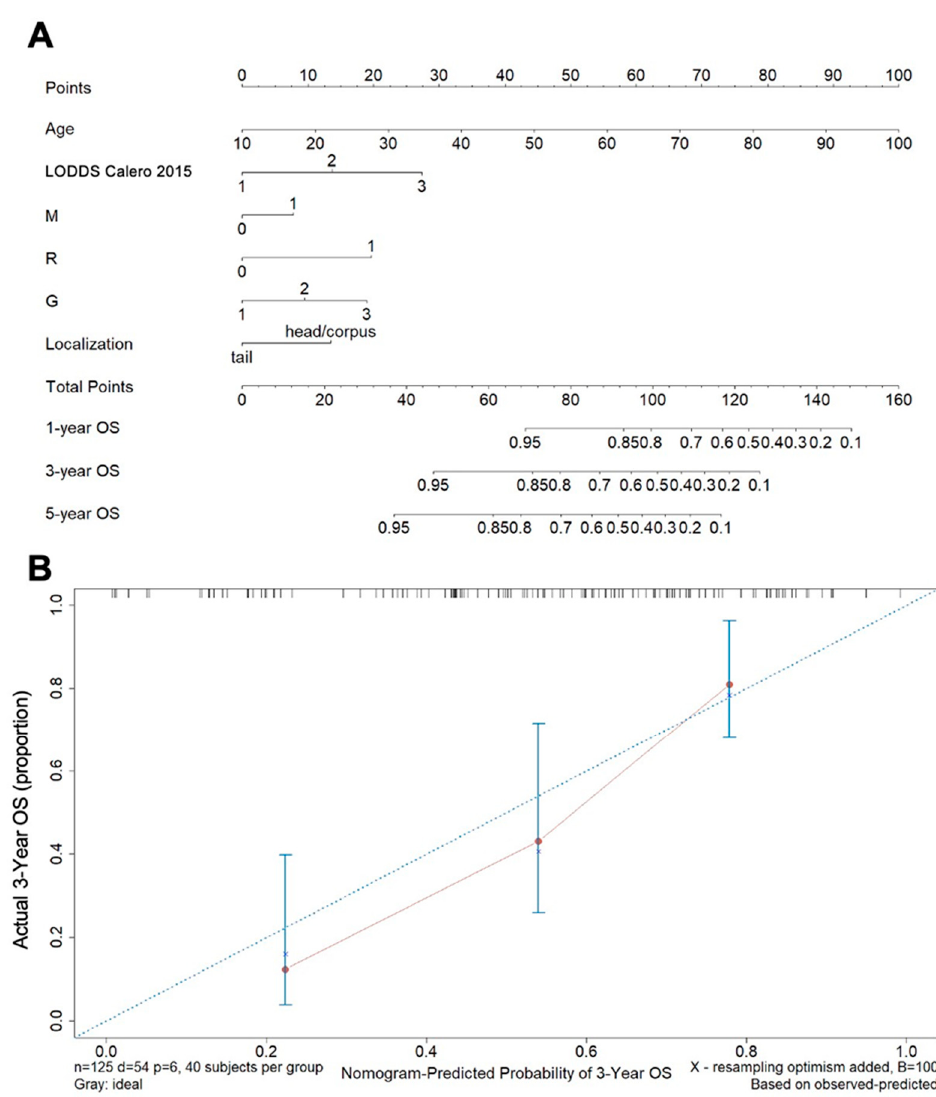
Figure 4. Nomogram for predicting patient survival probability. ( A ) A nomogram built out of the independent variables age, LODDS as reported by Calero et al. [16] presence of distant metastasis, resection margin status, differentiation and tumor localization predicting 1-, 3-, and 5-year OS. ( B ) The final model was validated by bootstrap resampling (B = 100 times) based on our data set and assessing the calibration curves.